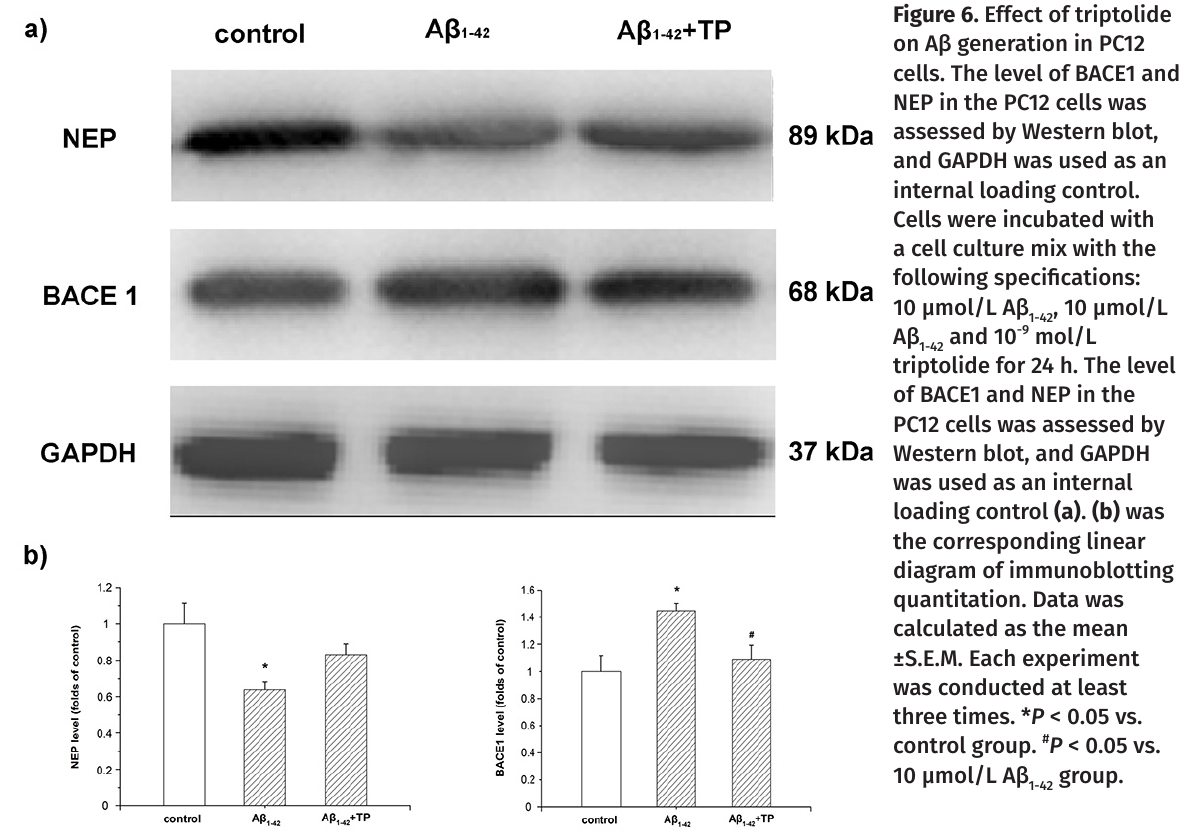
Figure 6. Effect of triptolide on Aβ generation in PC12 cells. The level of BACE1 and NEP in the PC12 cells was assessed by Western blot, and GAPDH was used as an internal loading